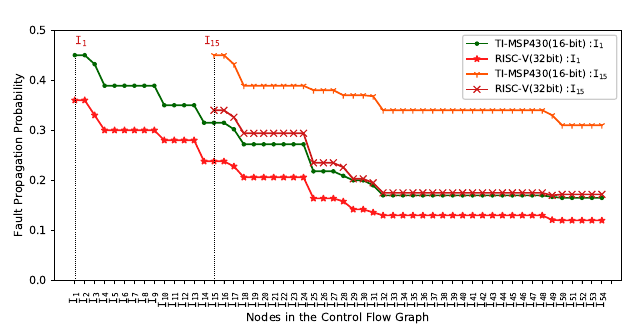
Figure 10: The fault propagation probability of instructions I 1 , I 15 for the processors TI MSP-430(16-bit) and RISC-V(32-bit) for the toy cipher implementation given in Figure 3. Table 3: We invoke FEDS [KRR + 20] in the Vulnerable Instruction Identification module for the five implementations considered. This step is hardware independent. Block Cipher #IR Instruction in the CFG % of Vulnerable Instructions Time (in Secs) AES-128(LookUp Table) 7206 6.56 38.2 AES-128(T Table) 4299 4.2 15.5 AES-128(BitSliced ) 8256 11.45 215.7 CAMELLIA-128 1475 23.2 99.3 CLEFIA-128 1024 6.54